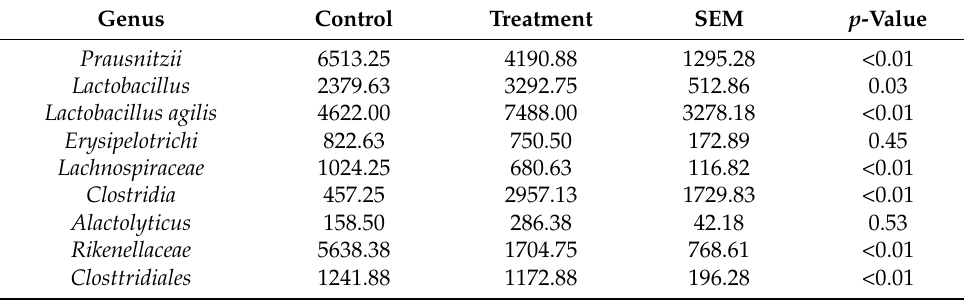
Table 8. Genus level significance analysis of cecal microbial community after 42 days.